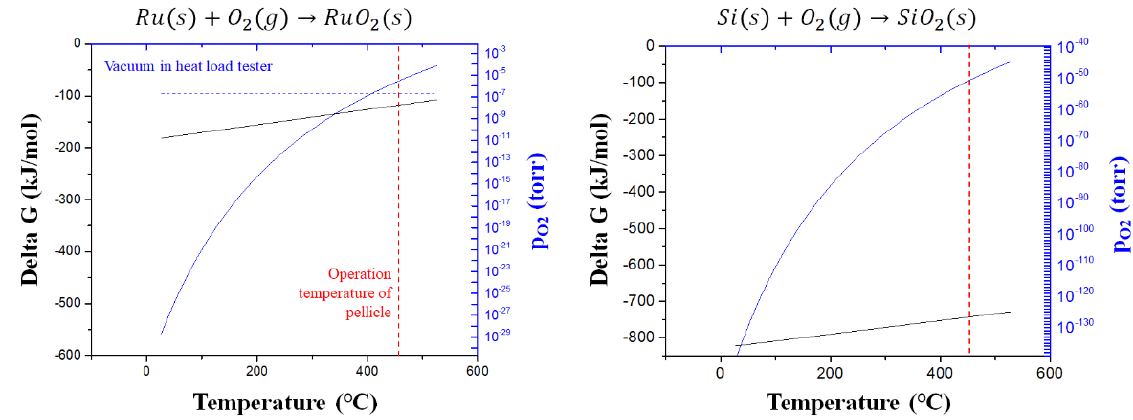
Figure 5. Gibbs free energy and equilibrium oxygen partial pressure based on the oxidation reaction temperature of Ru and Si.